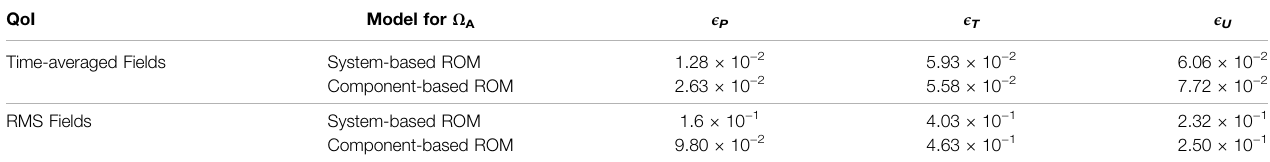
TABLE 2| Comparisons ofthe errors in predicting time-averaged and RMS fi elds ofpressure ( P ), temperature( T ),and axial velocity ( U ) correspondingto Figures 6B-D with different models (component-based ROM vs. system-based ROM) used for the upstream injector element for the single-injector combustor. QoI Model for Ω A 